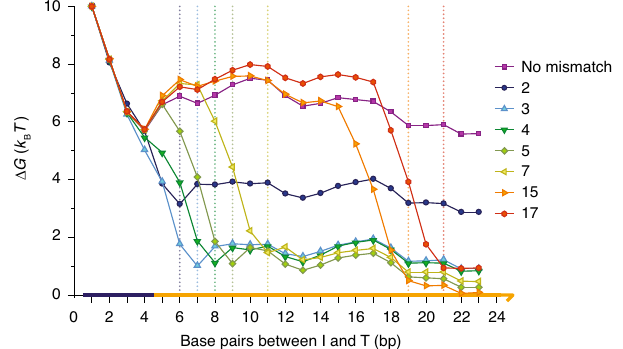
Fig. 4 Free-energy pro fi le of strand displacement. Simulated con fi gurations are assigned to macrostates based on the number of base pairs between I and T . Mismatch elimination is associated with a large drop in free energy that begins slightly before mismatch enclosure (dotted lines indicate the expected number of base pairs at the point of mismatch elimination). A mismatch at position 2 provides a smaller overall thermodynamic bias for displacement than mismatches at other positions. Estimated errors for individual points within a single simulation are highly correlated with other points. The over- all free energy change between 1 and 23 base pairs therefore gives the best characterisation of the sampling error: we fi nd a typical standard error of ~±0.2 k B T from n = 6 independent simulations (see Supplementary Table 23 for